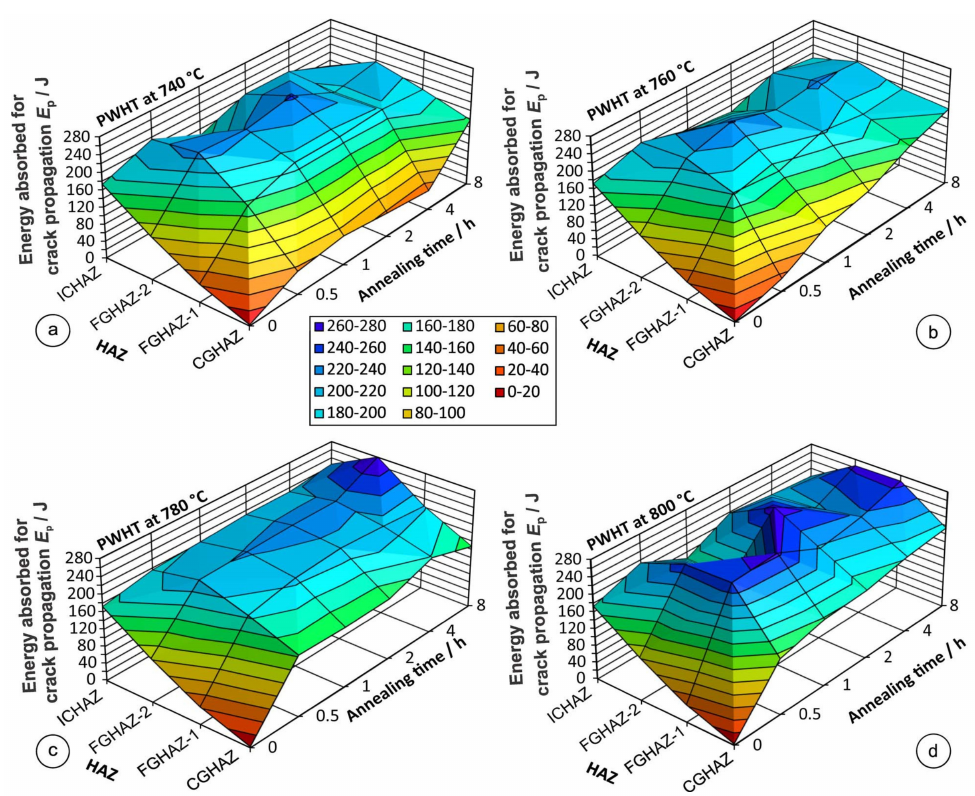
Figure 9. Crack propagation energies E p of HAZ subzones after PWHT at ( a ) 740 ◦ C; ( b ) 760 ◦ C; ( c ) 780 ◦ C; ( d ) 800 ◦